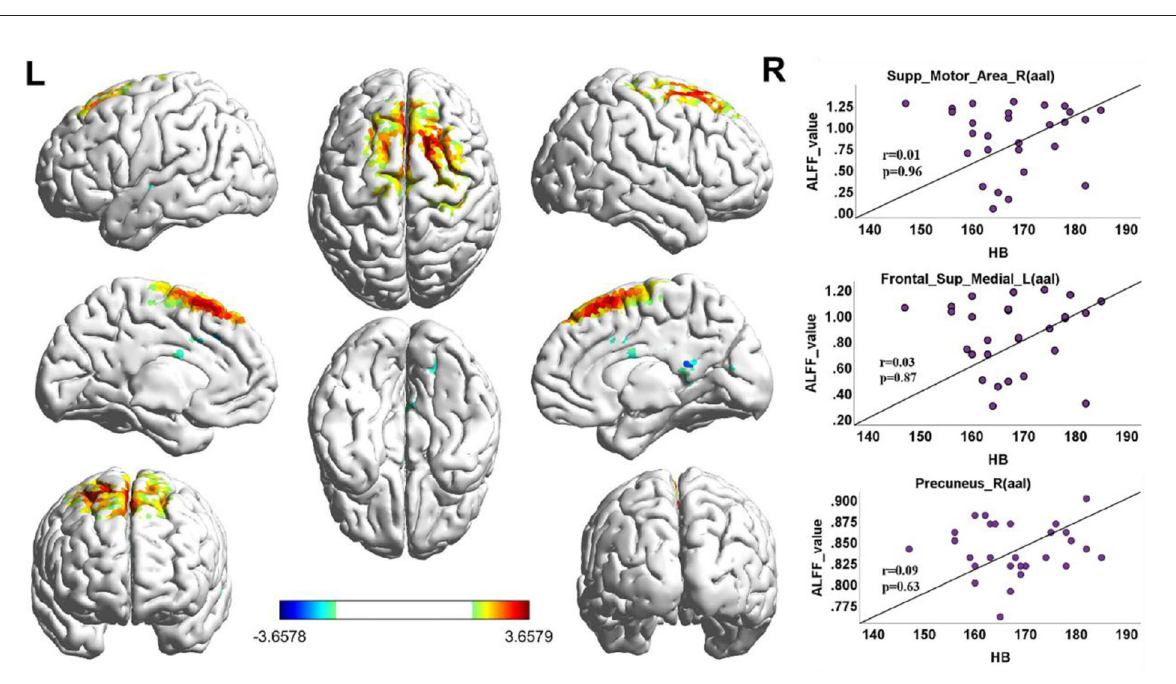
FIGURE3 ALFF cluster area and the correlation with Hb, dark red with a significantly increased value, and dark blue with a significantly decreased value; the color bar represents the t -score. ALFF value correlation with Hb in Spearman. Correlation diagrams display the right superior motor area (aal; r =